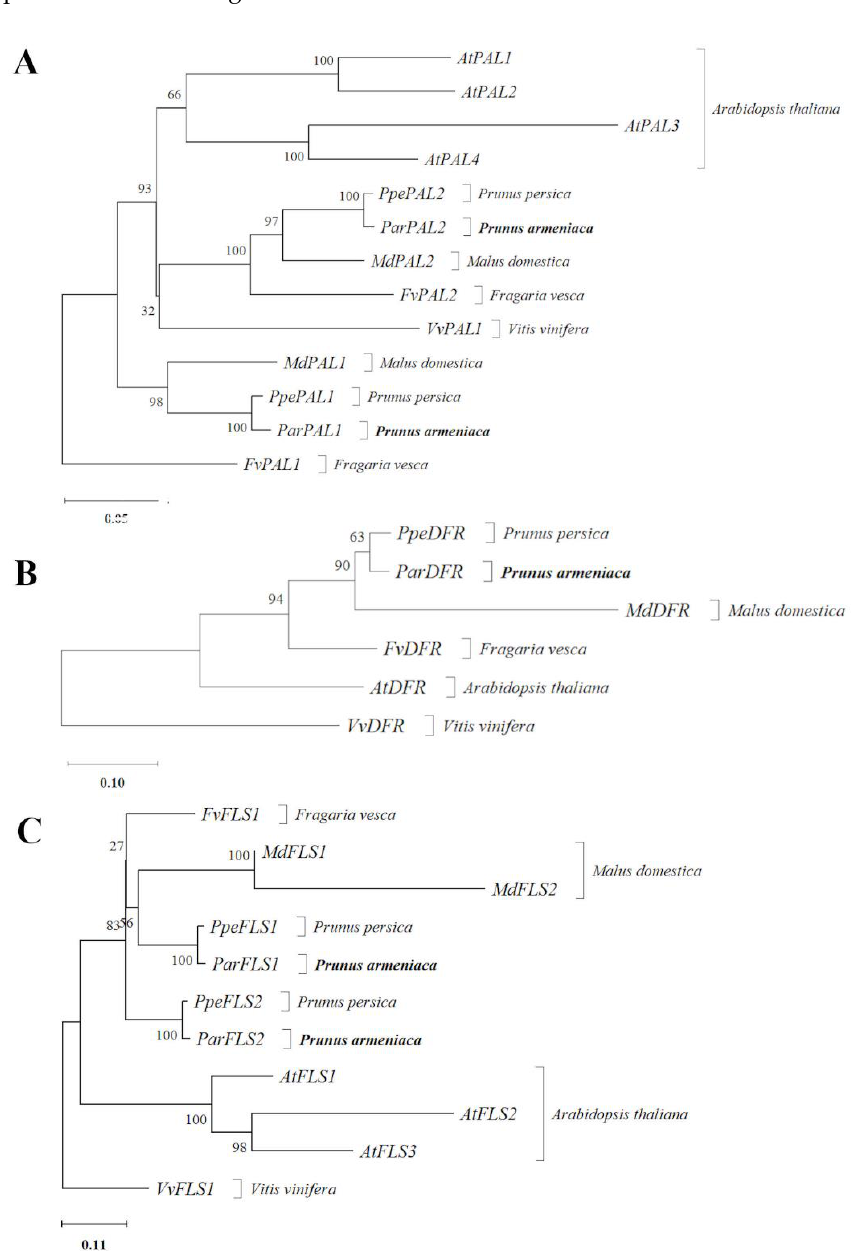
Figure 4. Neighbor-Joining phylogenetic tree for the proteins encoded by PAL ( A ), DFR ( B ), and FSL ( C ) genes. Each tree was bootstrapped 1000 times. Numbers close to each branch represent the percentage of replicate trees in which the associated taxa clustered together in the bootstrap test. Trees are drawn to scale according to evolutionary distances ( p -distance), included under each tree representing the number of substitutions per